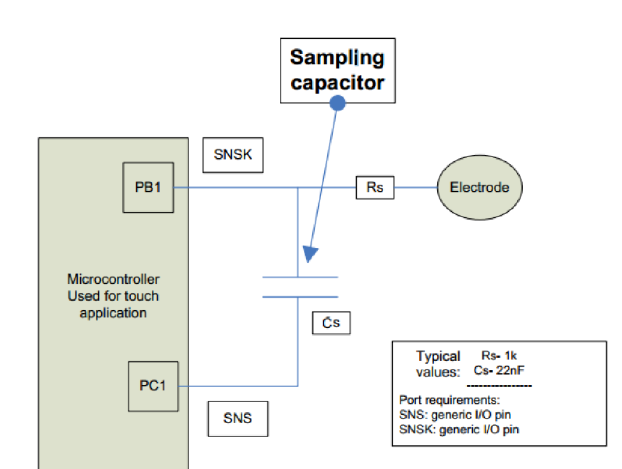
Fig. 5. Illustration of Atmel solution for capacitive acquisition based on the charge transfer. Electrode capacitance is